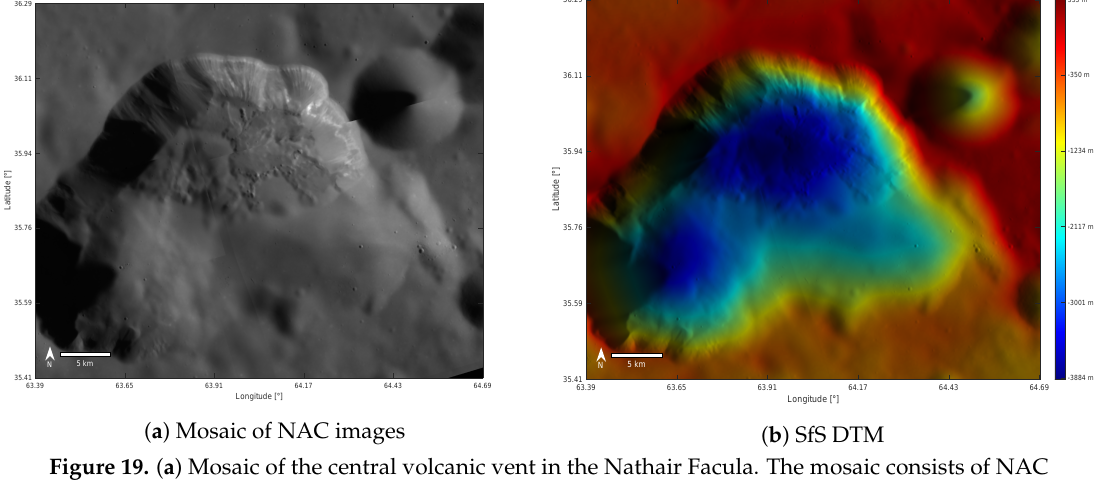
Figure 19. ( a ) Mosaic of the central volcanic vent in the Nathair Facula. The mosaic consists of NAC images and has a resolution of about 30m/pixel. There are some noticeable georeferencing errors. ( b ) Color-coded representation of the SfS DTM. The inaccuracies at the mosaic borders were reduced by the process but not completely eliminated. The different surface textures are modeled